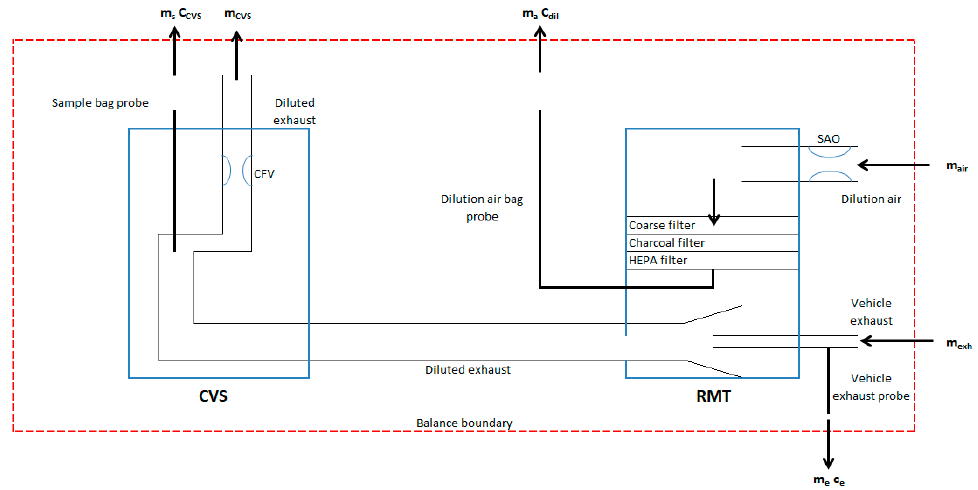
Figure 6. Mass balance area for the method of determining the DR dilution ratio by measuring the CO 2 concentration in the raw exhaust gas.